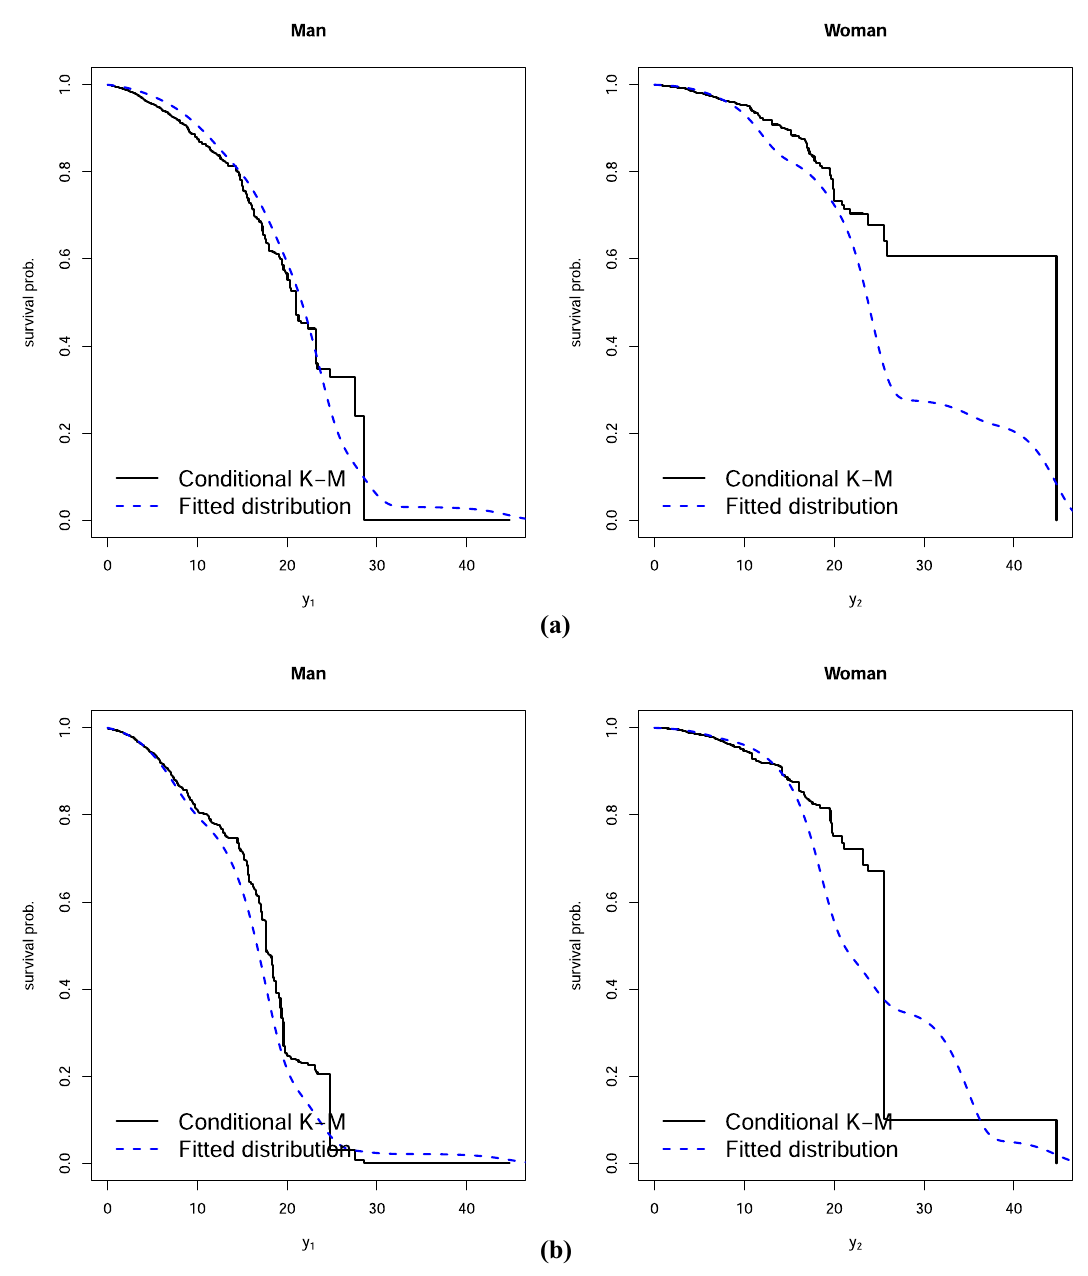
Figure 4: Conditional K - M estimators vs the fi tted distribution. ( a ) Couple 3. ( b ) Couple